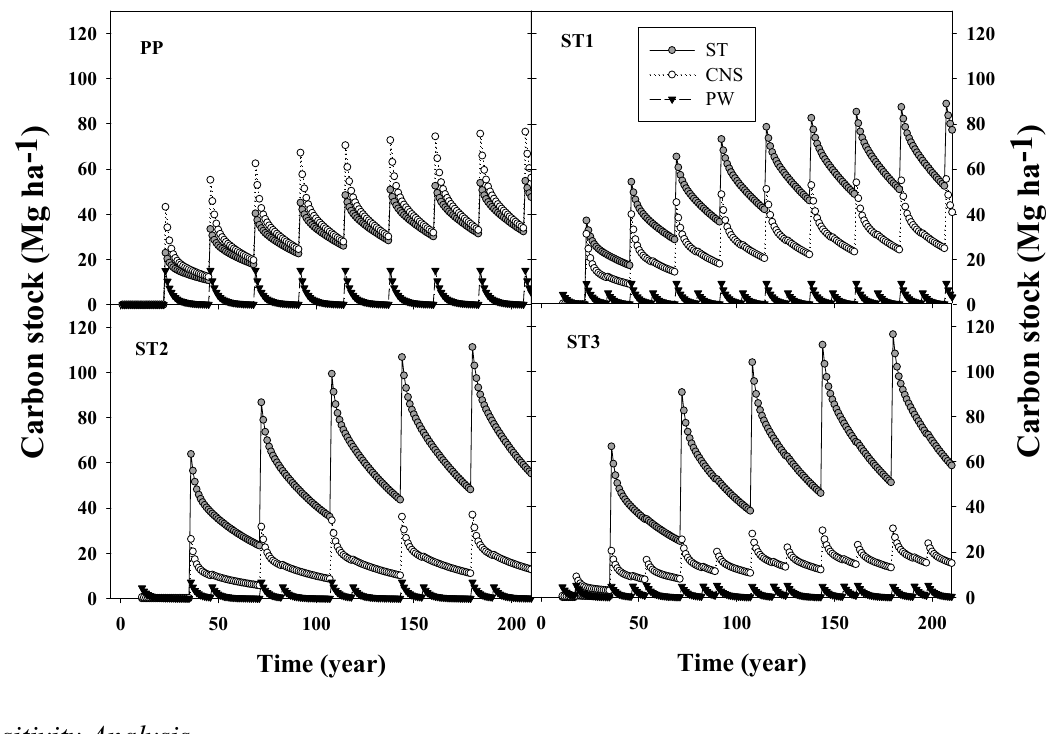
Figure 6. Annual carbon stocks in woody products for loblolly pine plantations under different silvicultural scenarios for a 200-year simulation